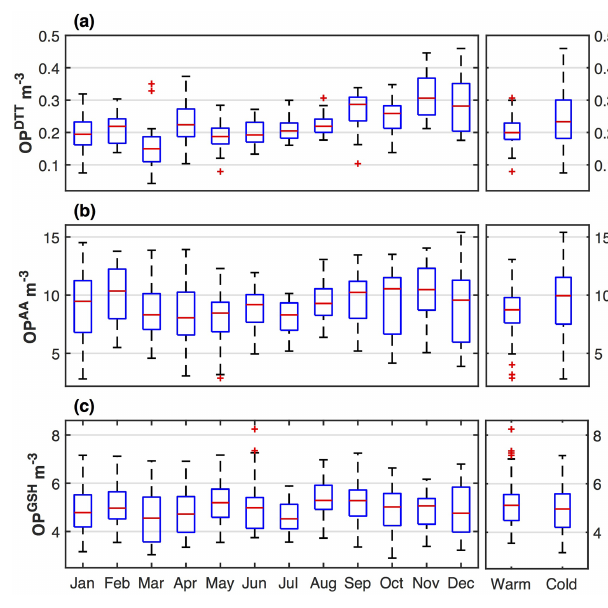
Figure 2. Temporal variation for (a) OP DTT m −